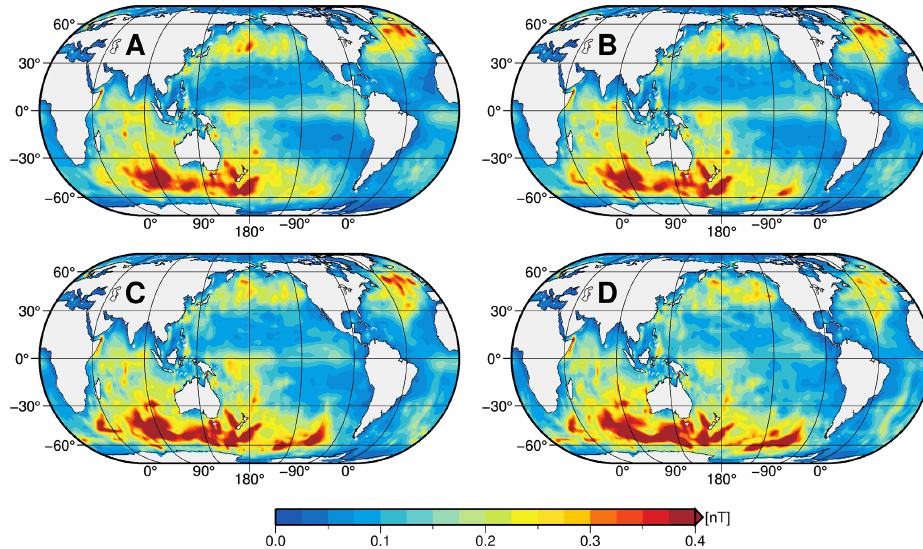
Figure A3. Annual temporal variability (standard deviation) of the ocean-induced magnetic field for scenarios A, B, C, and D with layer thicknesses of 1050, 1450, 2100, and 3000m,